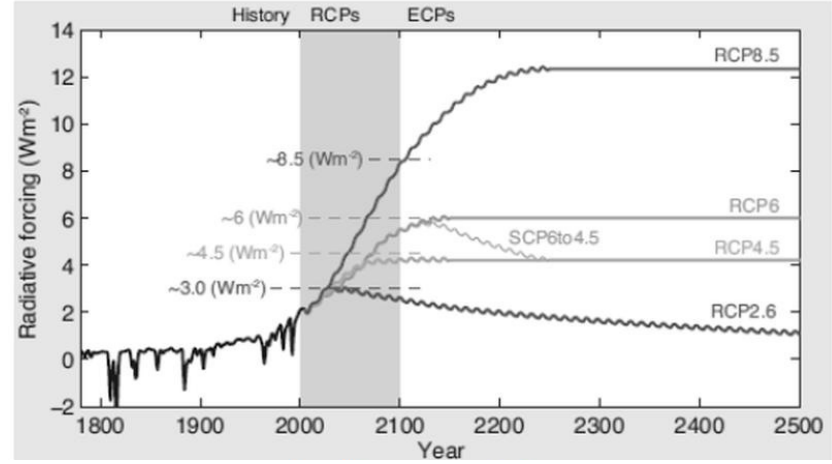
Figure 3. Representative Concentration Pathways (RCP) proposed for the 21st century based on Greenhouse Gas (GHG) emissions [18].